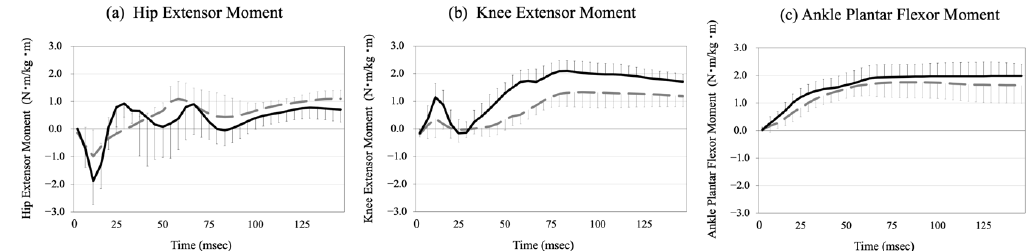
Figure 2. Moments curves over time, in lower extremity joints of the valgus and varus groups during drop vertical jumps (DVJ) landings. Means of the hip extensor ( a ), knee extensor ( b ), and ankle plantar flexor ( c ) moments, and the standard deviations of the valgus (solid black lines) and varus groups (broken gray lines) during landings of DVJ.